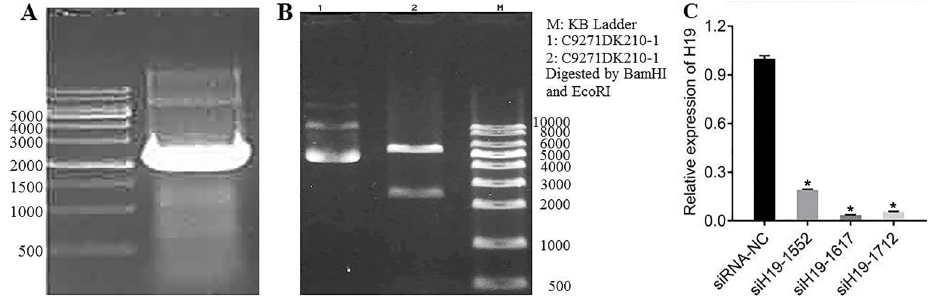
Figure 1. A , H19 PCR ampli fi cation electropherogram. B , Restriction endonuclease digestion of recombinant vector. C , Changes in H19 expression after silencing H19. Data are reported as means ± SD. *P o 0.05 compared to negative control (NC) (one-way analysis of